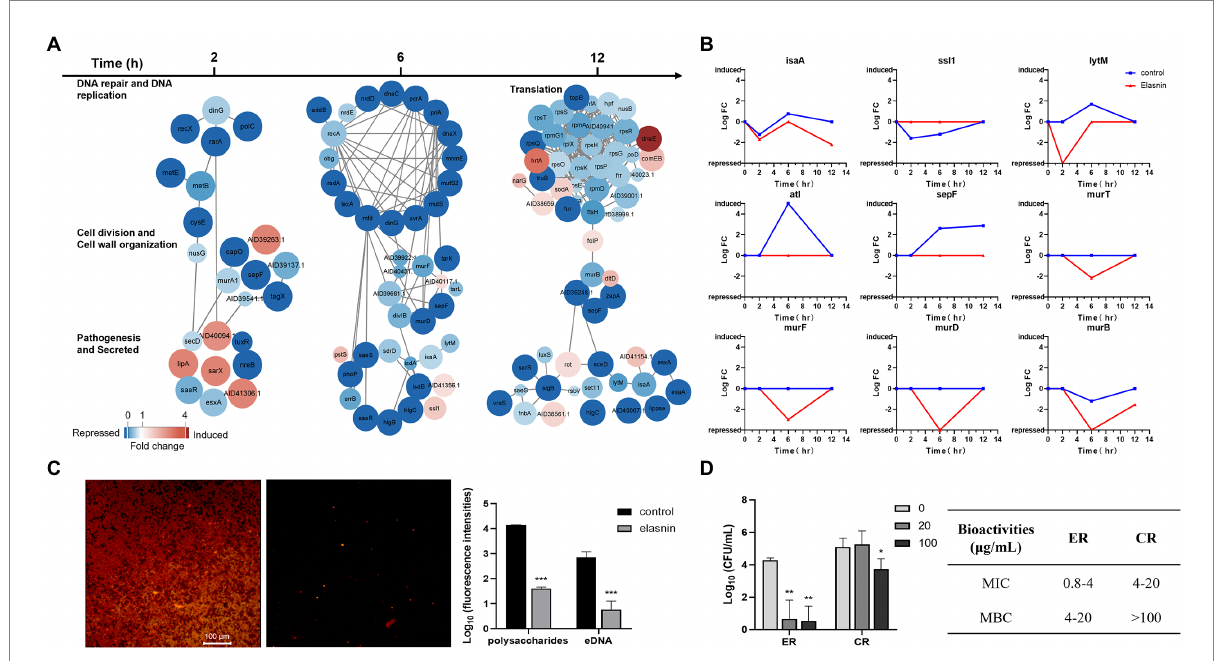
FIGURE 5 Elasnin interfered with cell cycle and EPS production and reduced the antibiotic resistance of MRSA. (A) Differentially expressed proteins in selected functional subsets after 2, 6 and 12 h of elasnin treatment. (B) Changes in the expression level of selected DEPs during the biofilm eradication with elasnin. (C) Effect of elasnin on the production of polysaccharides (red, stained with Concanavalin A) and eDNA (green, stained with TOTO-1) of MRSA biofilm, as visualised by confocal microscopy. Fluorescence intensities were calculated based on acquired 3D confocal images ( n = 3). Here, the polysaccharides and the eDNA were stained simultaneously. A separate staining image of polysaccharides alone and eDNA alone is shown in Supplementary Figure S4D. (D) Antibiotic susceptibility of MRSA cells against Penicillin G after being released from the biofilms ( n = 3). ER are the cells released from the biofilms after elasnin treatment, and CR are the cells released naturally (without any treatment). Differences between different groups were calculated by Student’s t -test and are indicated by asterisks as follows: *for p < 0.05, **for p < 0.01 and ***for p <